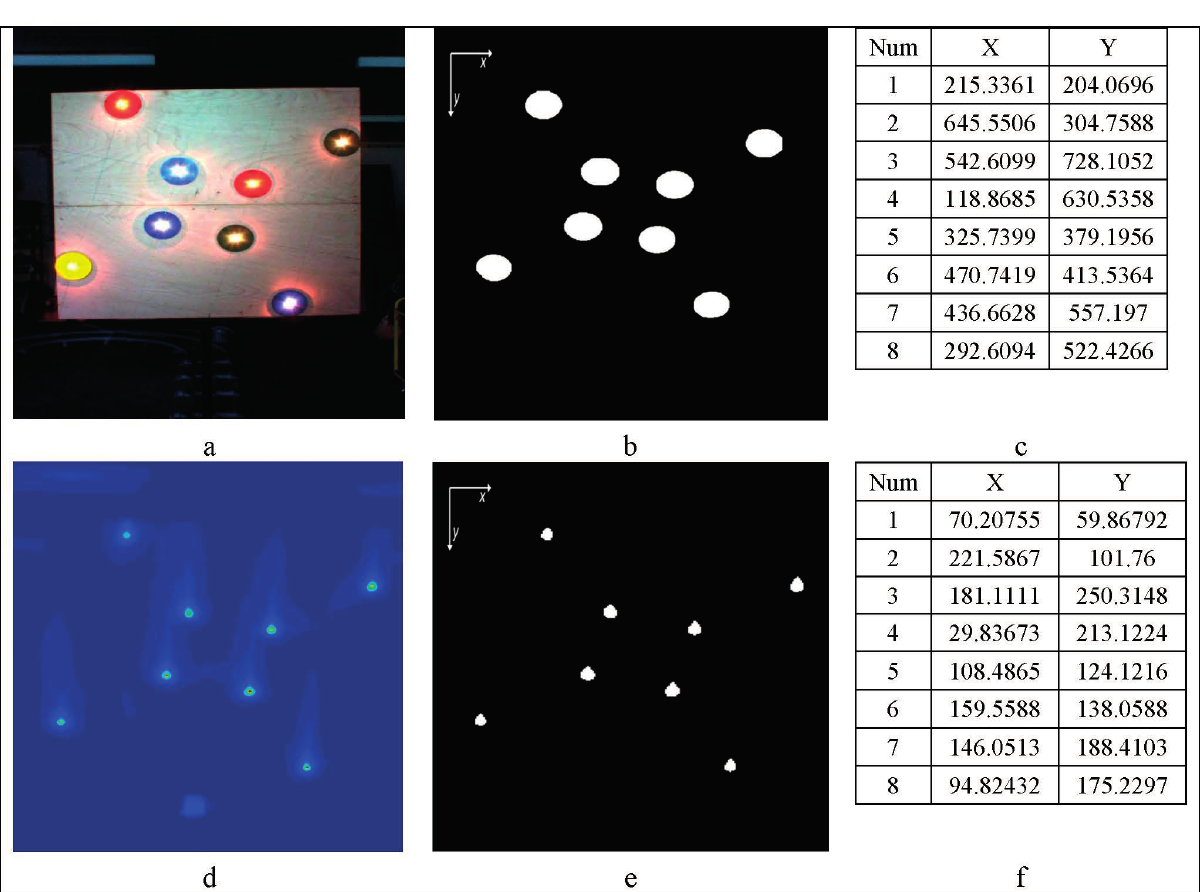
Figure 6. ( a ) visual image; ( b ) RGB ACPs positions, ( c ) RGB ACPs position; ( d ) thermal image; ( e ) thermal ACPs position; ( f ) ACPs position; ( c , f ) are sorted according to Figure